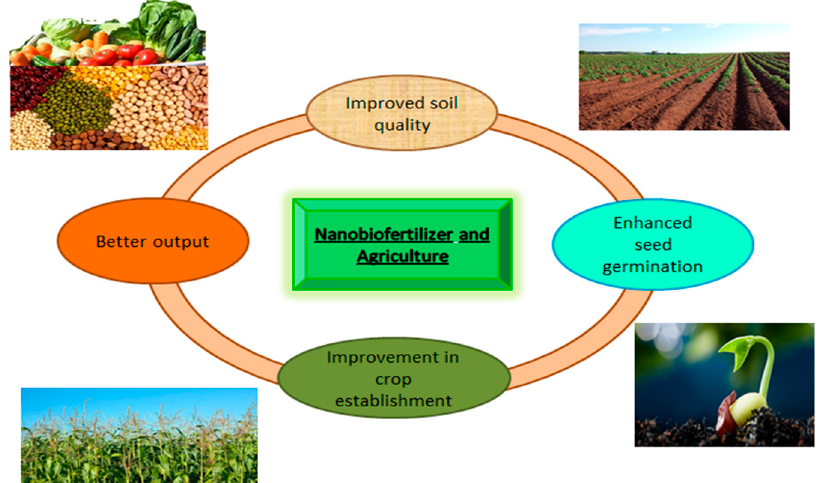
Figure 1. The basic role of nanobiofertilizer.